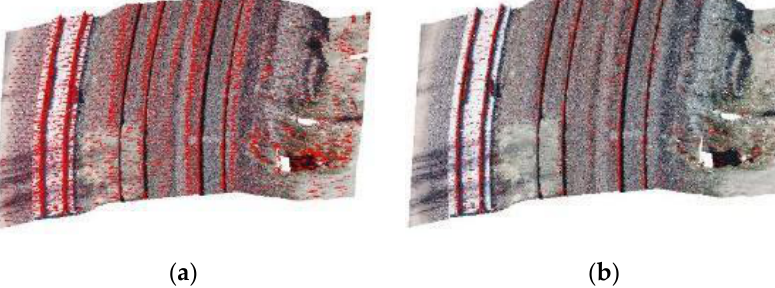
Figure 6. Extraction of rail candidate points (red) by height jump detection; ( a ) before and ( b ) after intensity and planarity conditioning.